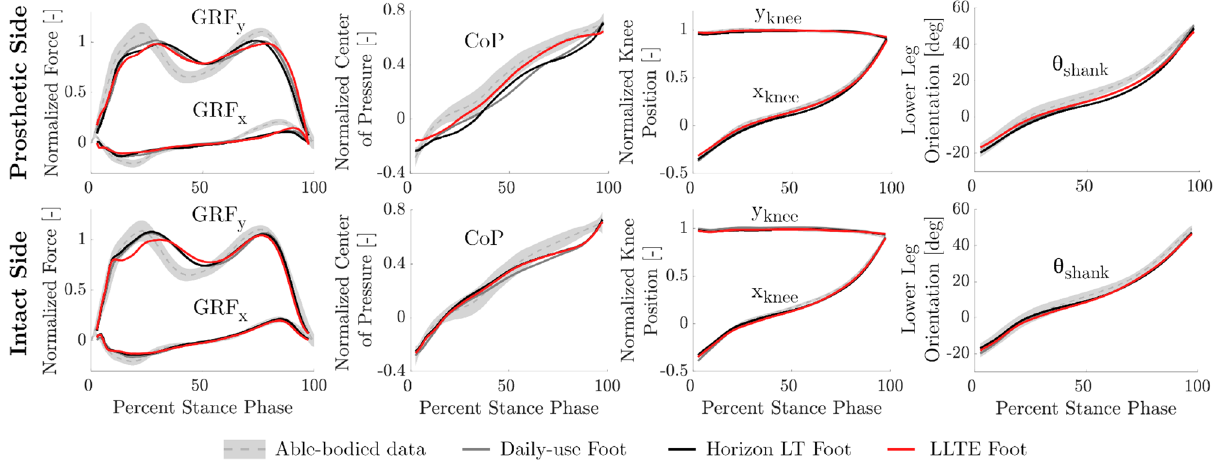
Figure 4. Average kinetic and kinematic variables over the entire stance phase for each prosthetic foot type averaged across all participants. This includes horizontal and vertical ground reaction forces ( GRF x and GRF y ), center of pressure progression (CoP), and lower leg position and orientation in the sagittal plane ( x knee , y knee , and θ shank ). Results are shown for both the prosthetic and intact side, and compared to the corresponding reference physiological data 30 used in the LLTE framework to optimize the feet. The shaded regions correspond to one standard deviation of the normative physiological data.